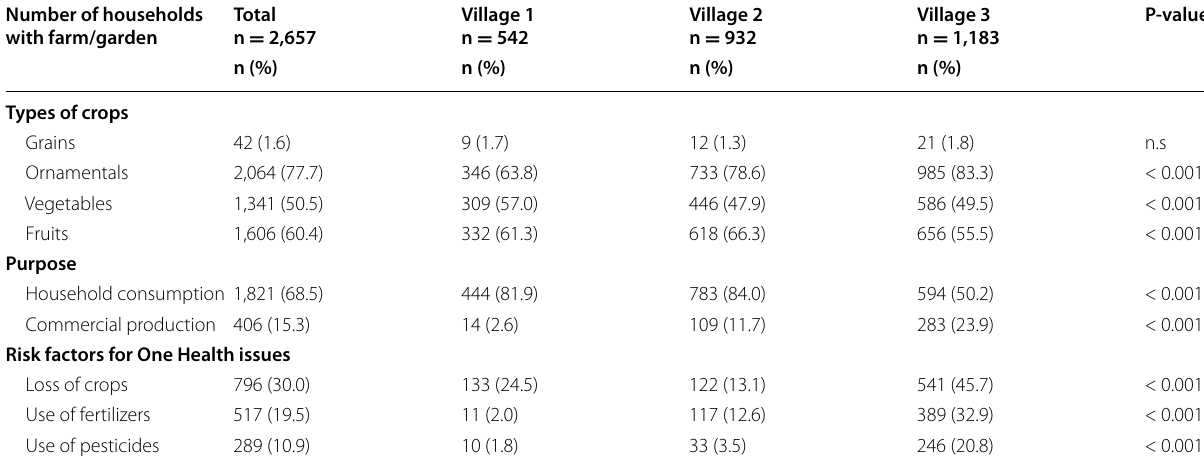
2,657 households) =